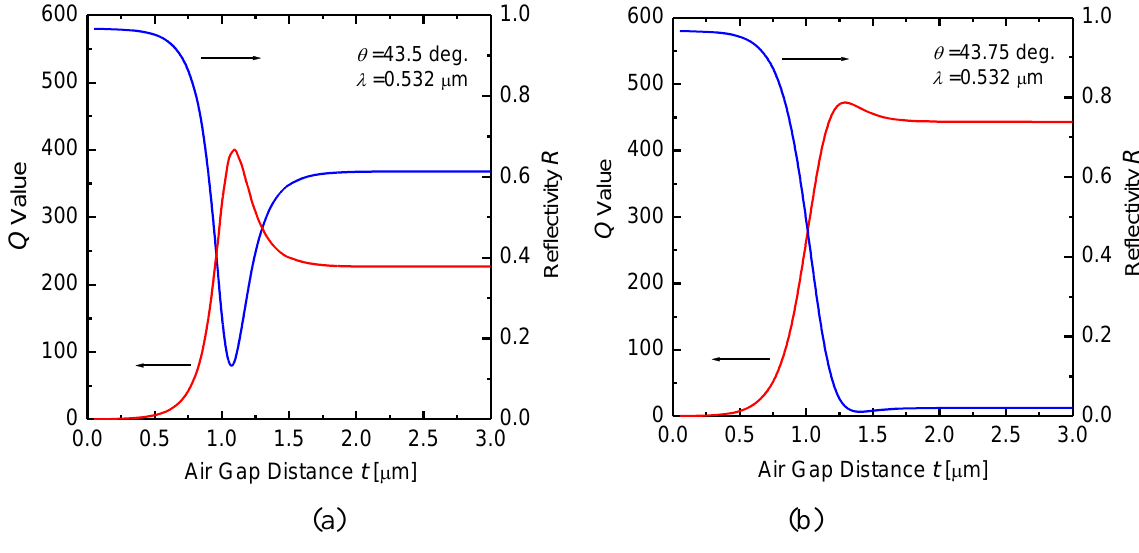
Figure 5. Calculated Q -value and reflectivity R of the microcavity as a function of air-gap distance t : (a) at  = 43.5° (the low angle side of the ATR dip); (b) at  = 43.75° (the ATR dip